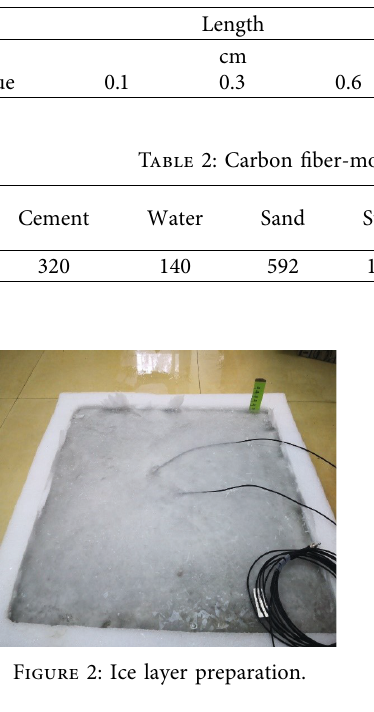
Table 1: Main technical specifications of carbon fiber.